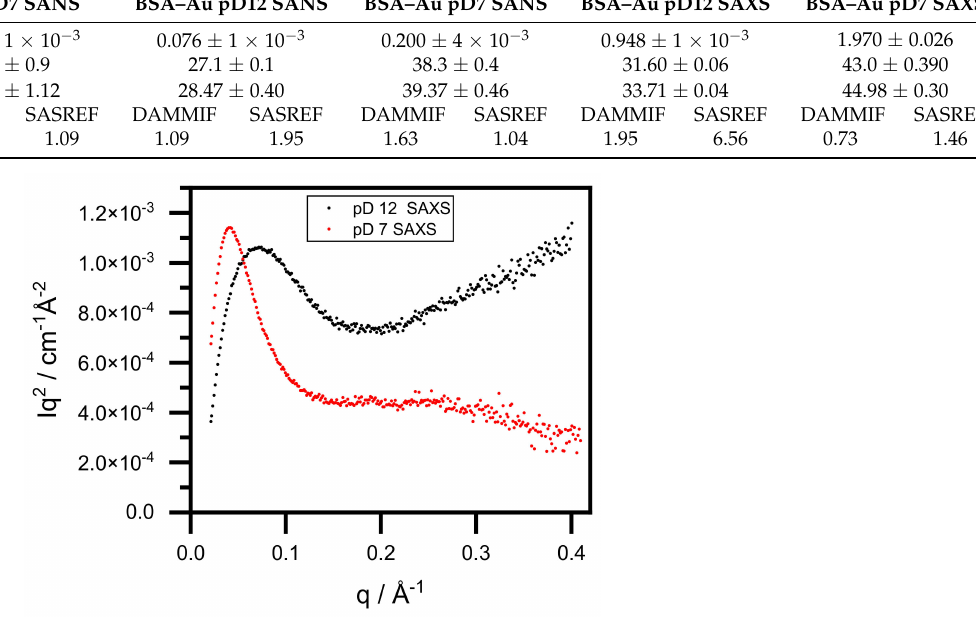
Figure 4. Kratky representation of small-angle X-ray scattering curves of BSA–Au conjugates at pD ~12 and pD